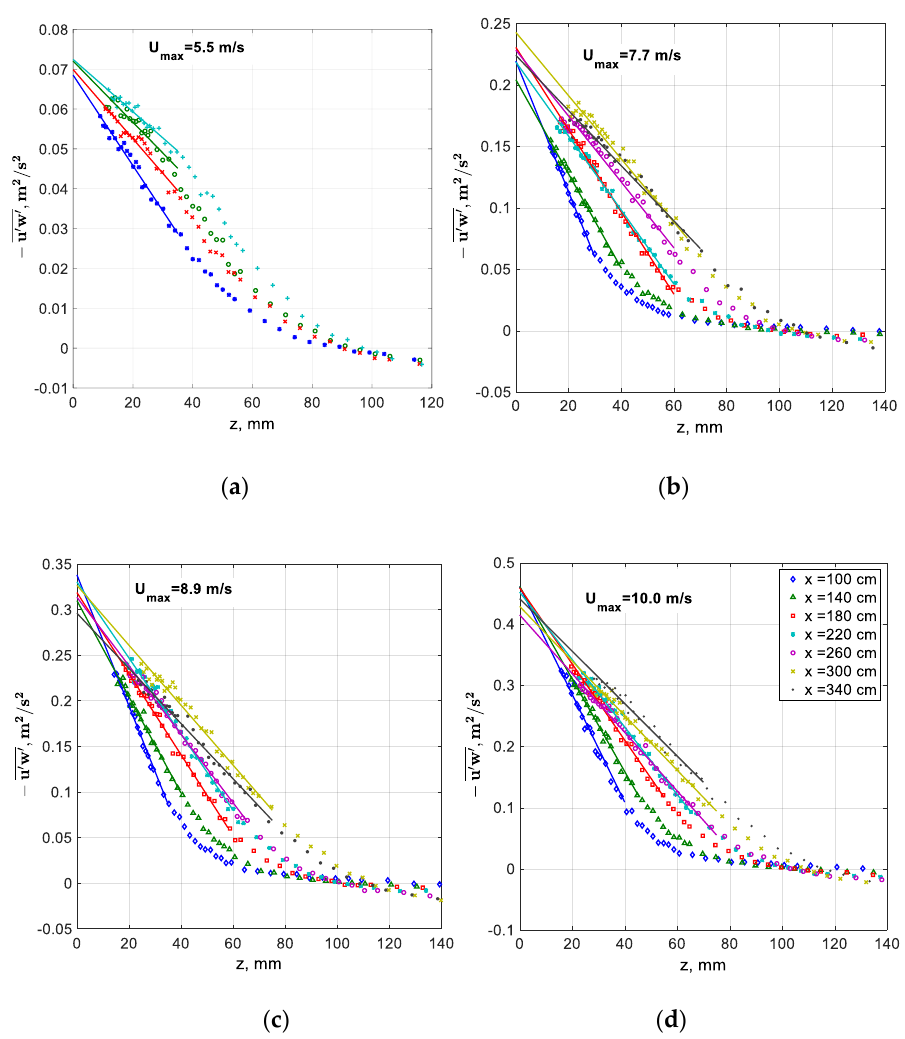
Figure 4. Distribution of the Reynolds stress − u (cid:48) w (cid:48) above the mean surface level for various wind velocities. The solid lines show the linear fit for each fetch. Panels ( a )–( d ) correspond to different wind velocities